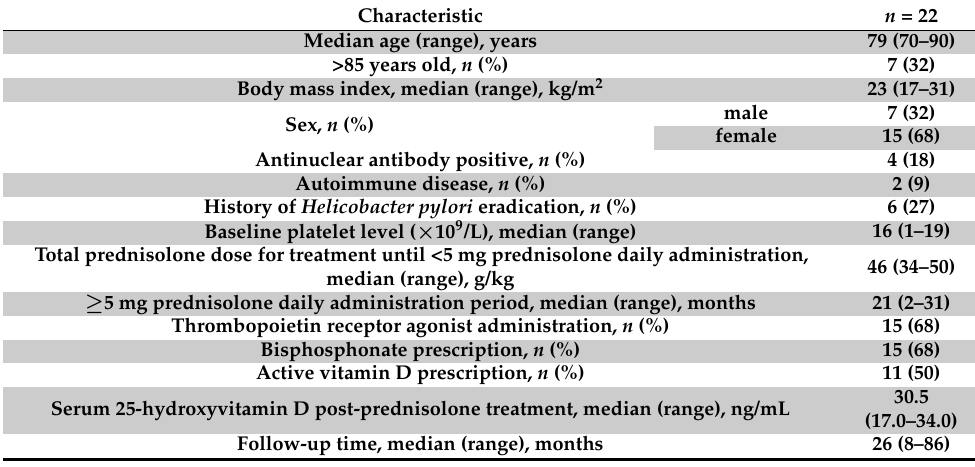
Table 1. Characteristics of patients with immune